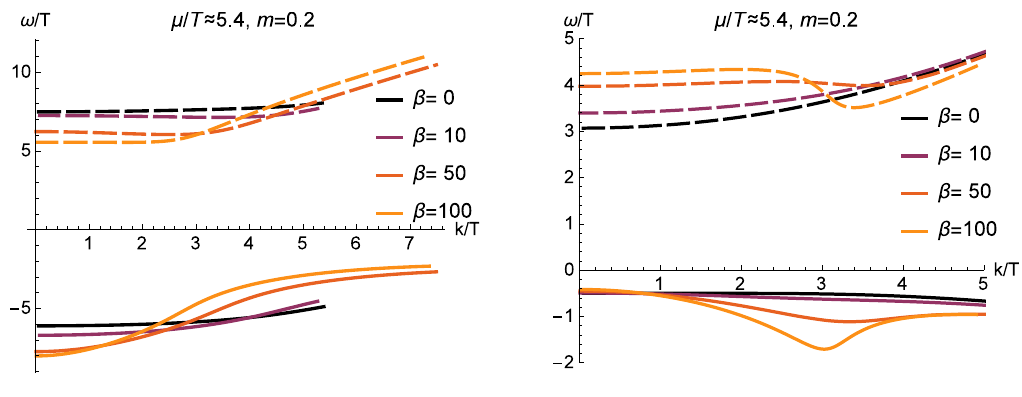
Figure 11 . The gapped QNM (left) and CM (right) at (cid:22)=T (cid:25) 5 : 4, m = 0 : 2.